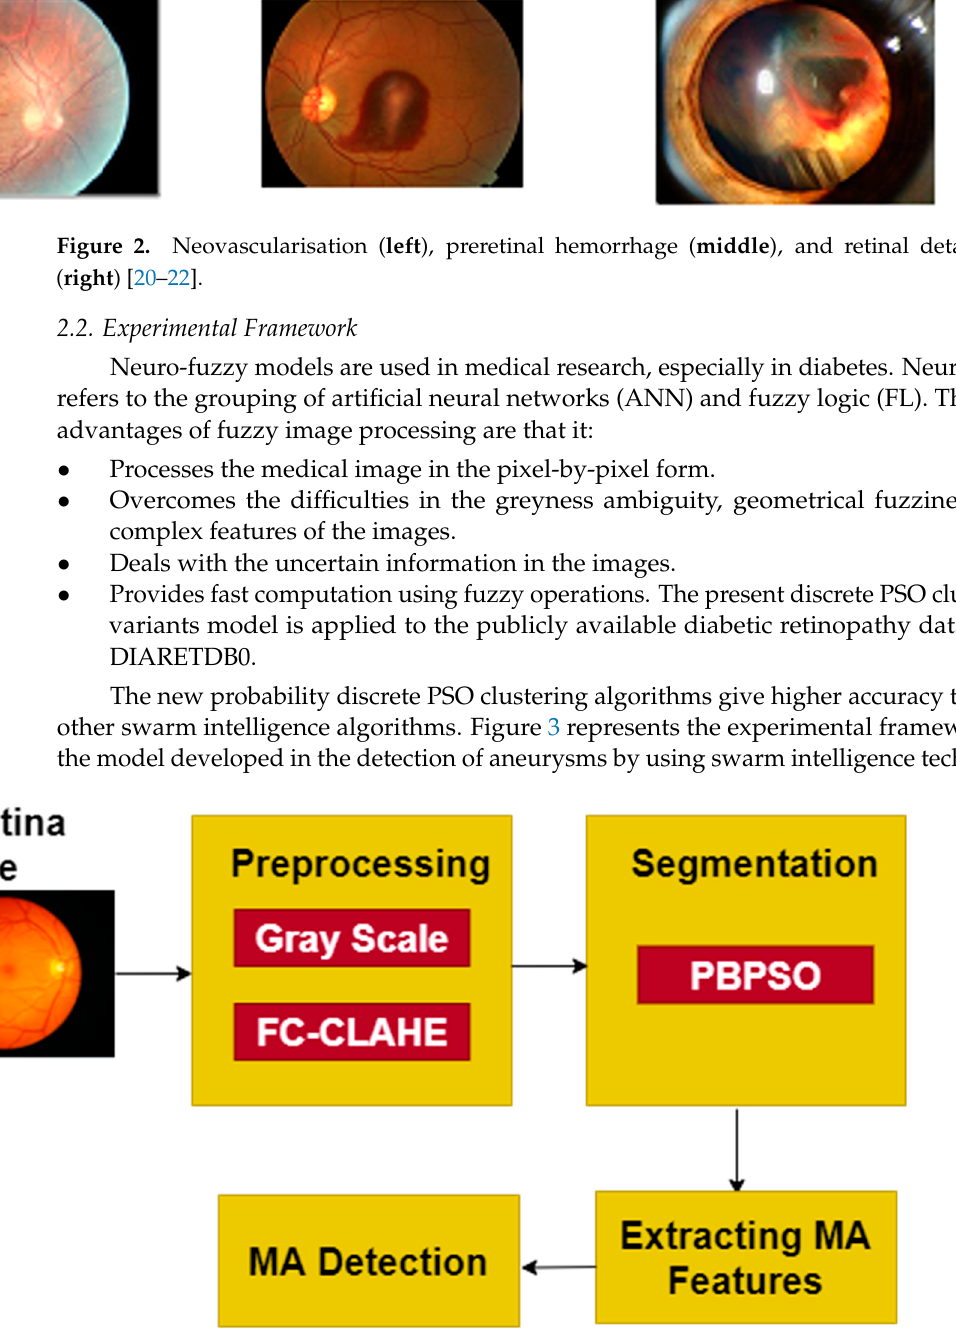
Figure 3. A proposed experimental framework.